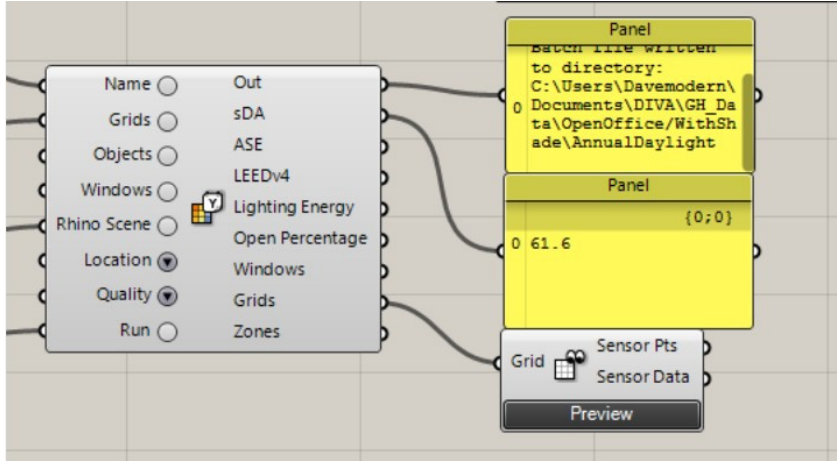
Figure 19. sDA Value for Proposed Model at 61.6%.